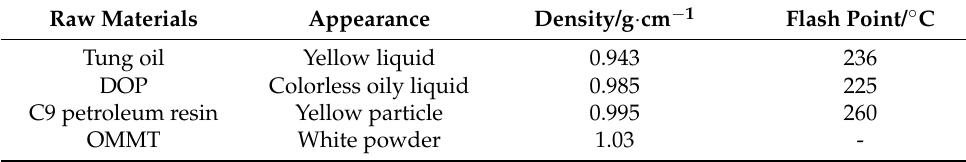
Table 1. Technical indexes of tung oil.